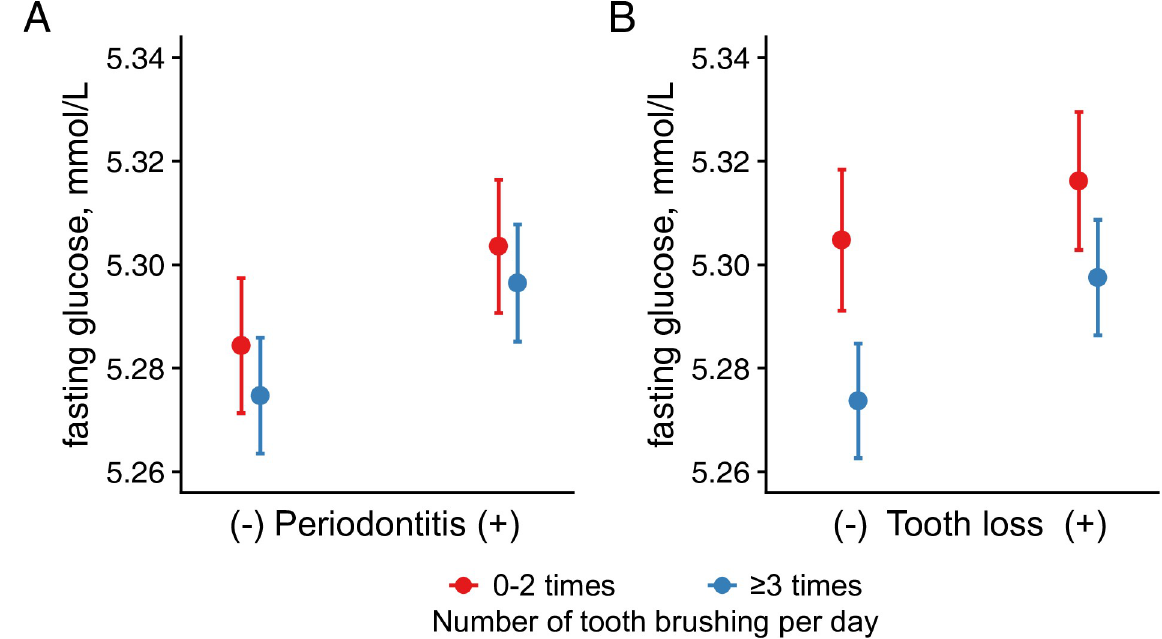
Fig 2. Fasting glucose levels according to the number of tooth brushing considering the periodontitis and tooth loss. Data are presented as mean and 95% confidence intervals of fasting glucose level derived from multivariable linear mixed models considering the interactions. There is no significant interaction effect (A: p for tooth brushing � periodontitis = 0.701, B: p for tooth brushing � tooth loss = 0.101).